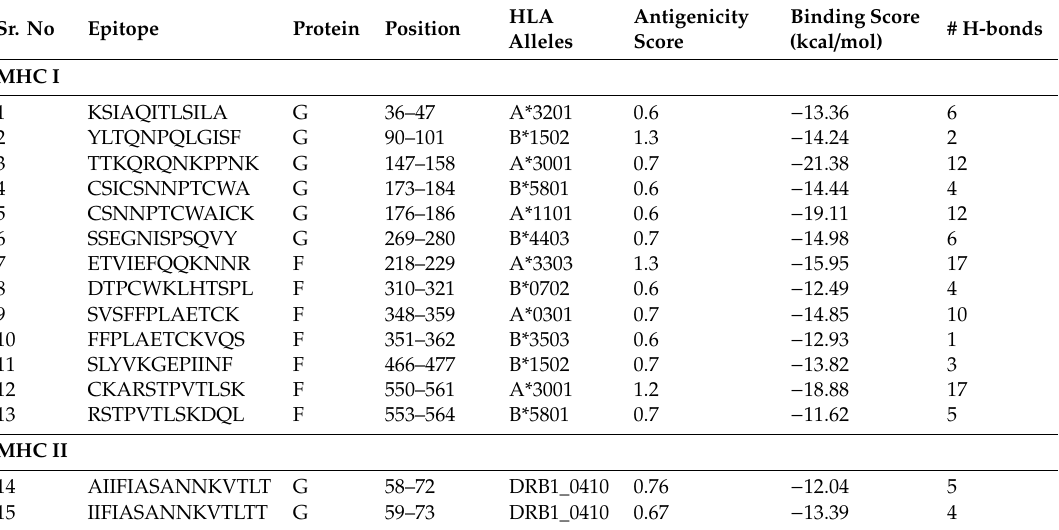
Table 2. Final selected epitopes from RSV antigenic proteins used to design the multiepitope-based subunit vaccine (MEV) construct and their binding details with their respective human leukocytes antigen (HLA) alleles. (#: number of H-bonds) Sr. No